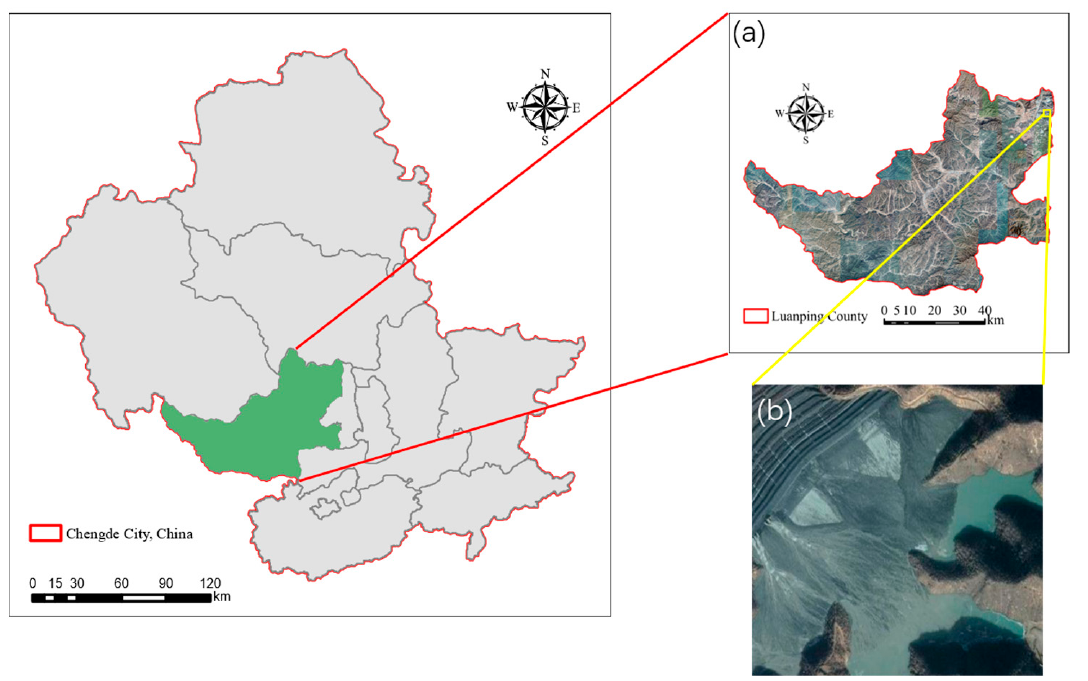
Figure 6. The geographical location of Luanping County in Chengde City, Hebei Province, China. ( a ) Luangping County; ( b ) tailings ponds in the remote sensing image.